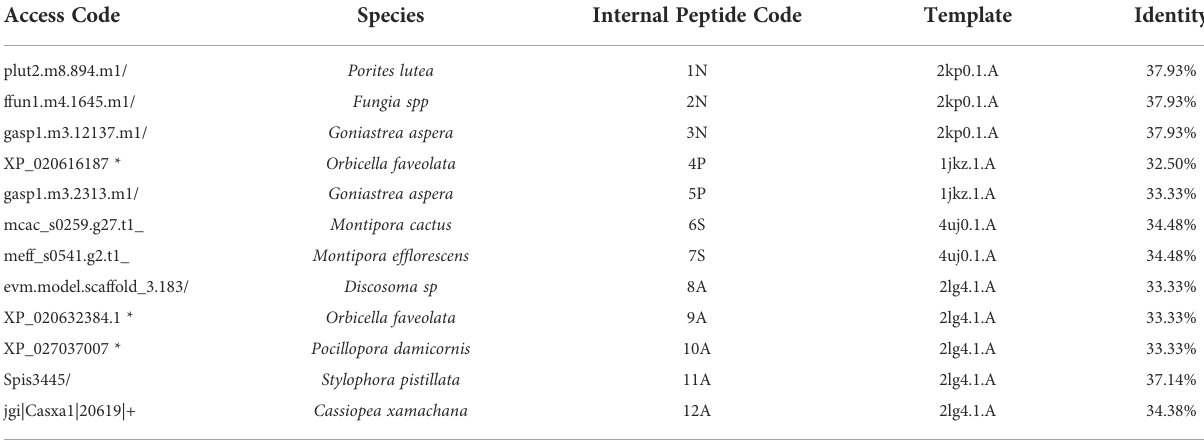
evm.model.scaffold_3.183/